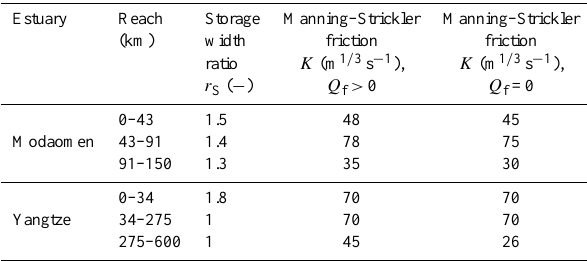
Table 5. Calibrated parameters of the estuaries